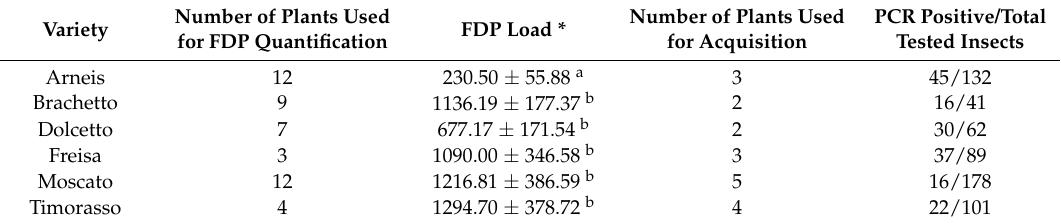
Table 1. Mean Flavescence dorée phytoplasma (FDP) load measured for different cultivars, expressed as FDP cells/ng plant DNA ± Standard Error, and acquisition from different grapevine varieties expressed as FDP-PCR-positive Scaphoideus titanus out of total tested insects.